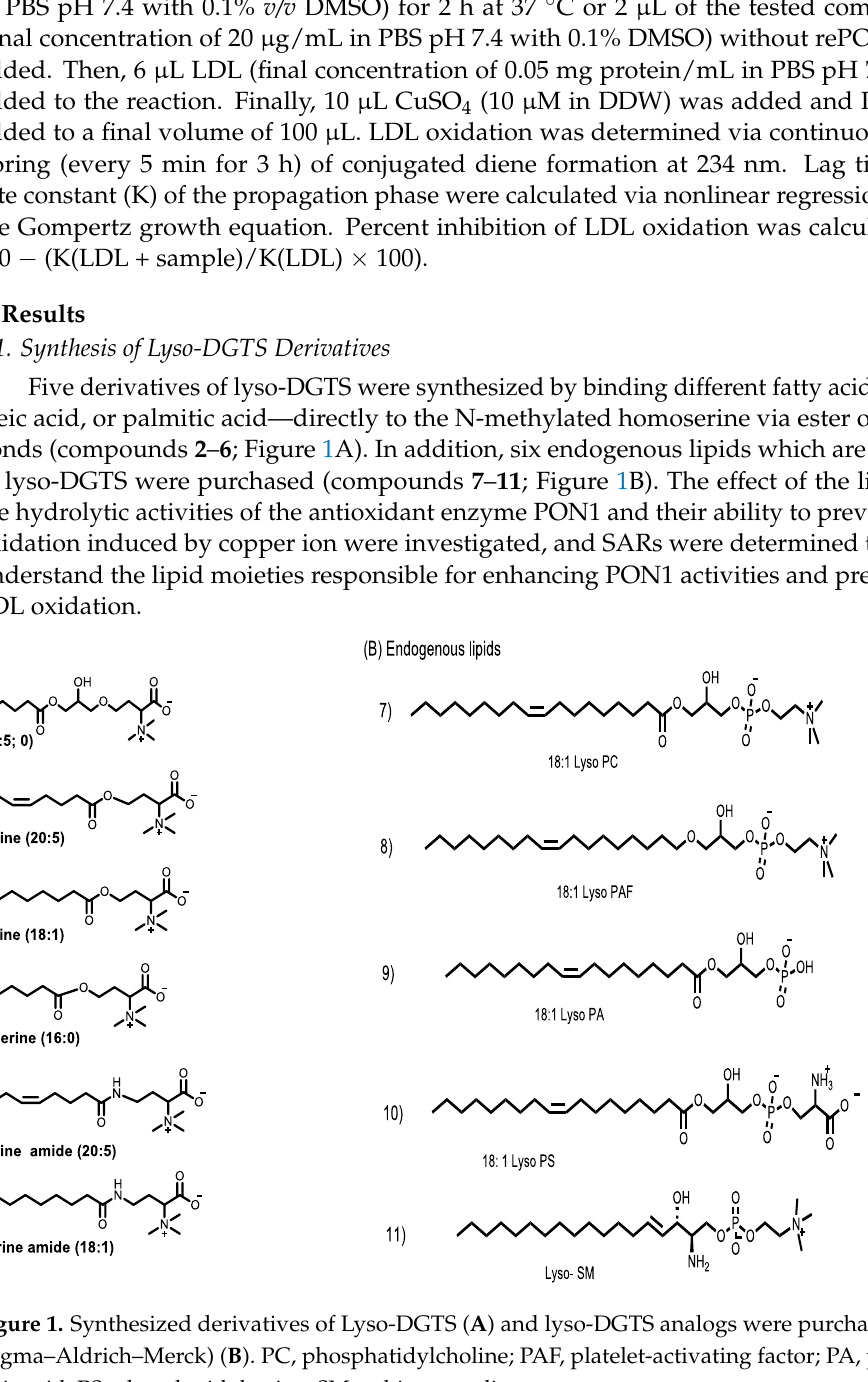
Figure 1. Synthesized derivatives of Lyso-DGTS ( A ) and lyso-DGTS analogs were purchased from (Sigma–Aldrich–Merck) ( B ). PC, phosphatidylcholine; PAF, platelet-activating factor; PA, phospha- tidic acid; PS, phosphatidylserine; SM, sphingomyelin.